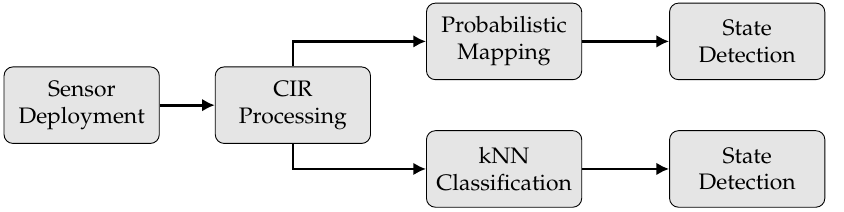
Figure 4. Flowchart of data processing and computation steps for radio sensing state detection.